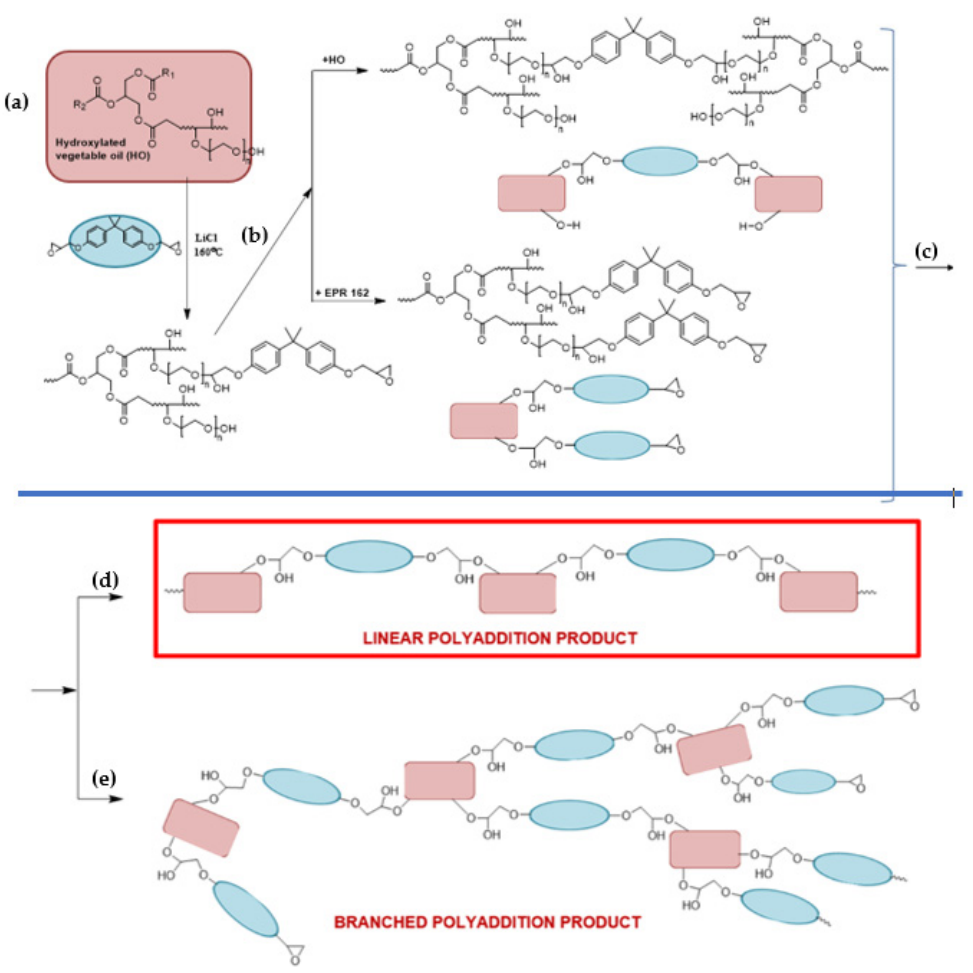
Figure 5. The SMEG_EPR epoxy fusion process: ( a , b ) 1st step—polyaddition reaction of hydroxyl soybean oil and low- molecular-weight epoxy resin, ( c ) reaction of the dimer formed in the first stage of the polyaddition process, ( d ) formation of a linear fusion product, and ( e ) formation of a branched SMEG_EPR_BPA product. However, in the critical moment, which is called the gelation point, the reaction mix- ture converts into the solid form with insoluble cross-linked polymer (Figure 6).